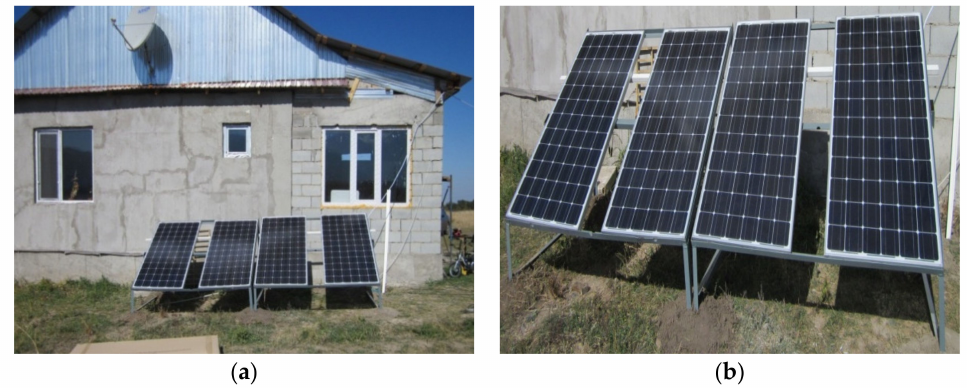
Figure 2. Photovoltaic panel ( a ) A building used to evaluate a temperature control system; ( b ) a photovoltaic panel used to measure solar radiation. The size of the room: length, 10 m; width, 9 m; height, 3 m; window area = 80 m 2 ; wall area, 0.105 m 2 . Technical characteristics: maximum heating temperature, 70 ◦ C; heating power, 8000